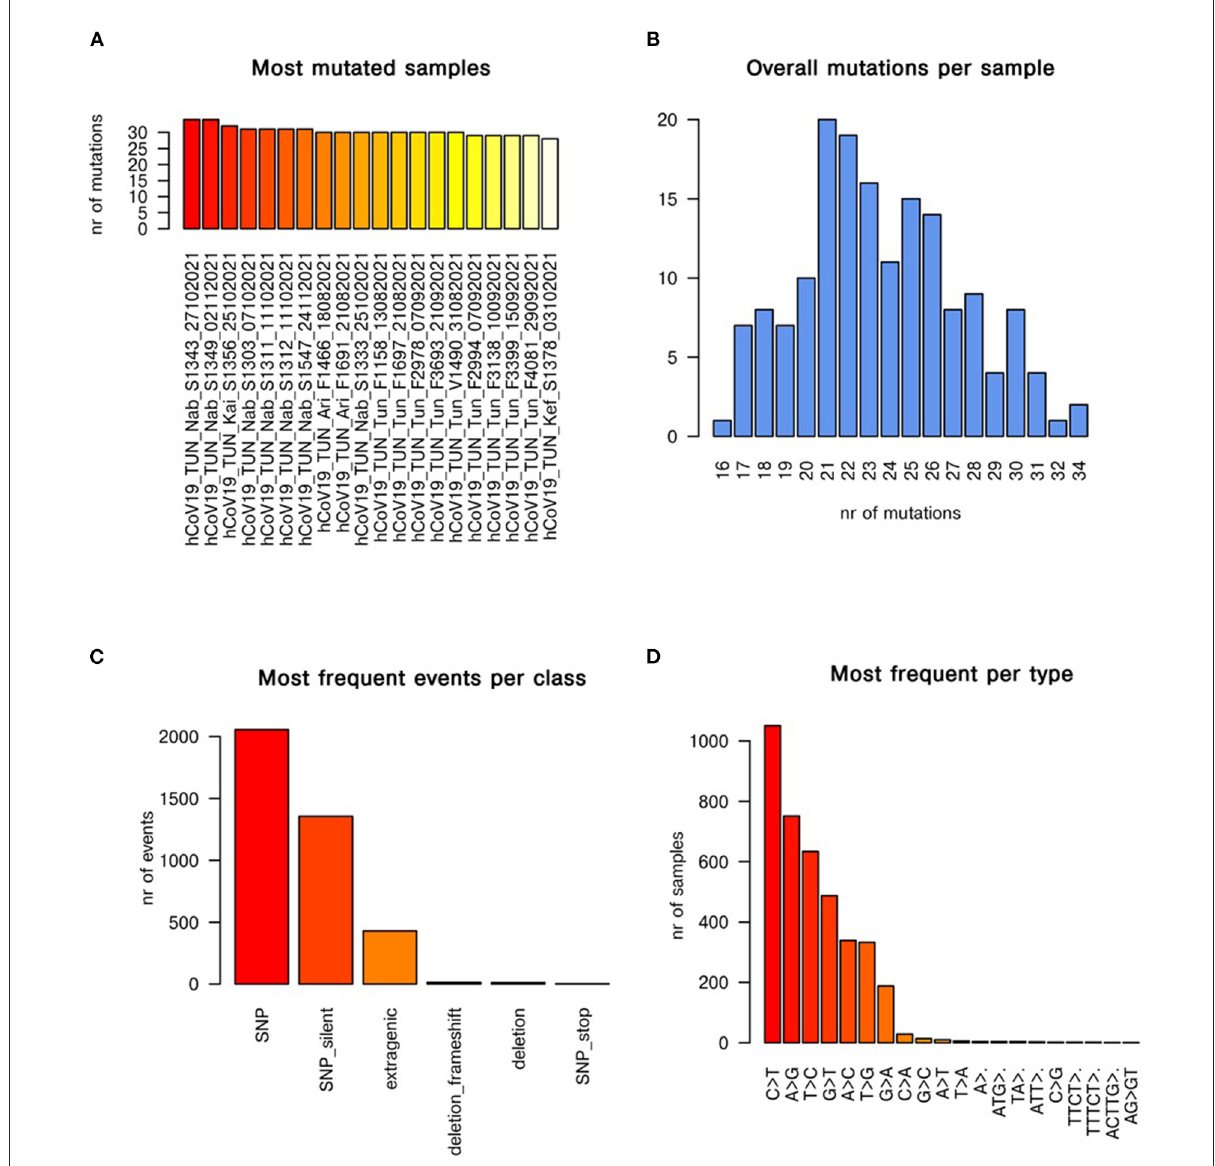
FIGURE4 Mutational cascade of AY.122 variant emerged in Tunisia with respect to first reported AY.122 strain. The panels (A–D) show the most mutated samples, mutations per sample, most frequent events per class of mutation, most frequent mutational events per type, respectively.